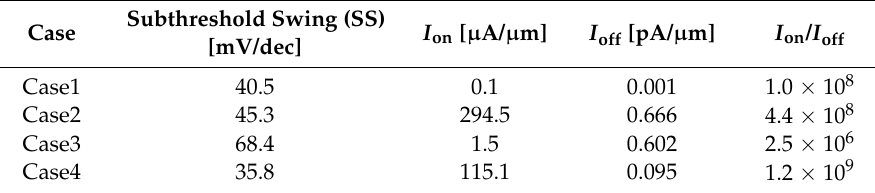
Table 2. Comparison of the electrical characteristics of Case1–Case4